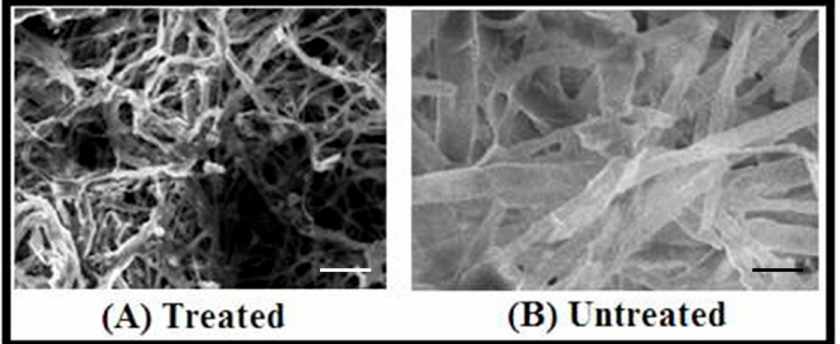
Figure 8. Images of scanning electron microscopy (SEM); ( A ) (treated): Damaged hyphae of Diplodia seriata due to treatment with ZnNPs, ( B ) (untreated): Showing normal mycelial growth of Diplodia seriata . Bar scale—5 µ